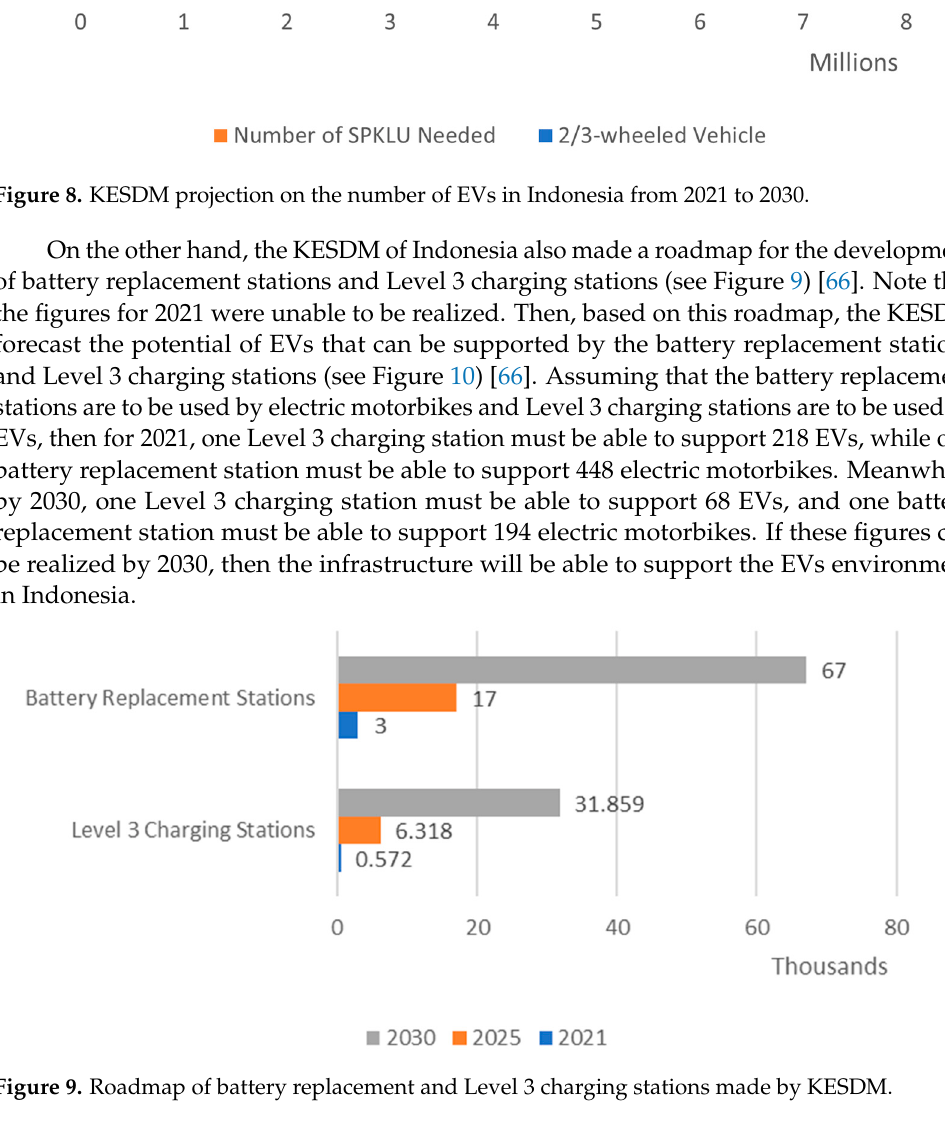
Figure 10. Potential of EVs based on the roadmap in Figure 9 made by KESDM. The average Indonesian sales growth is about 6%, while production growth is around 7.5%. EVs contribute to about 0.02% of total vehicle sales [67]. These sales were dominated by HEVs. Even so, there is still an increasing trend in EV sales. As also stated in the current study by McKinsey, the demand for EVs in Indonesia might increase significantly. The analysis stated that Indonesia could boost its demand for EVs by developing more local talent, establishing R&D hubs, and transferring the capabilities from foreign experts and global leaders to local staff [68]. Gupta and Hansmann proposed three scenarios: reference, accelerated, and lagging scenarios [69]. The reference scenario found that the demand for EVs might grow into 250,000 units per year by 2030, representing 16% of vehicles sales. This number is way below the number that can be supported by the projected Level 3 charging stations in 2030 (see Figure 11), showing that the roadmap for Level 3 charging station development is